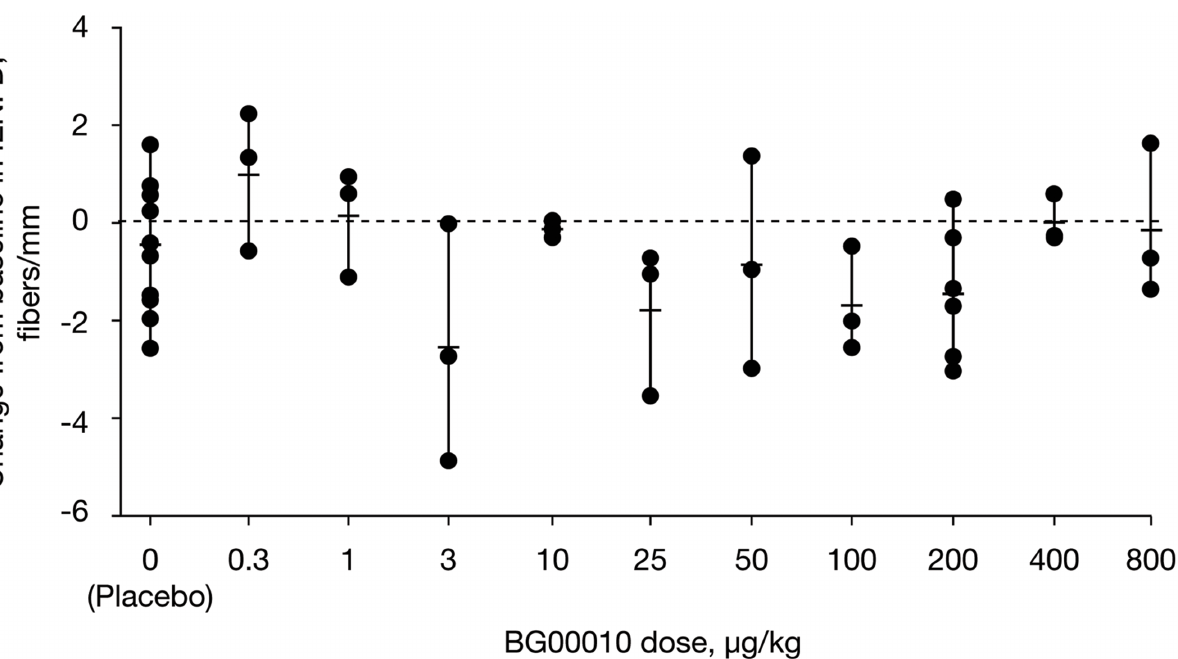
Fig 4. Change in IEFND between baseline and day 28. Data points indicate data for individual subjects following intravenous administration of BG00010 or placebo; lines indicate mean and range. IEFND, intra-epidermal nerve fiber density.